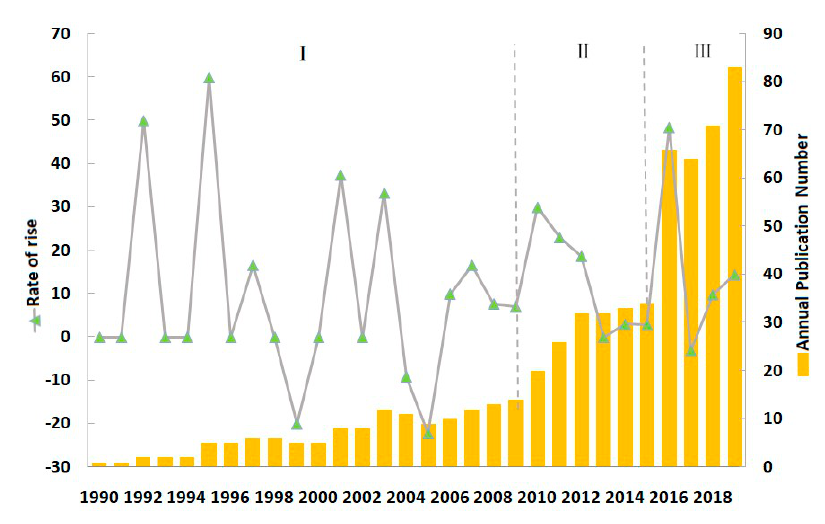
Figure 1. Annual publication outputs on ISI Web of Science data for the search topic ocean big data.